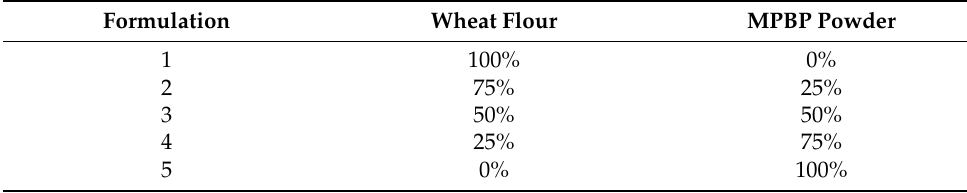
Table 1. Description of wheat flour/MPBP batter formulations.